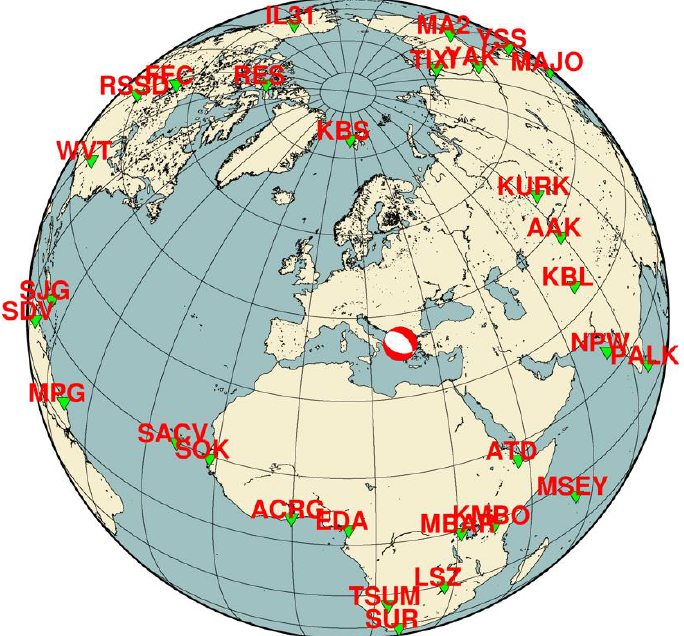
Figure 4. Geographic distribution of the teleseismic stations at epicentral distances (30° < Δ < 90°) from where P-wave records of the 3 March 2021 earthquake were used; beach-ball shows the earthquake focal mechanism.